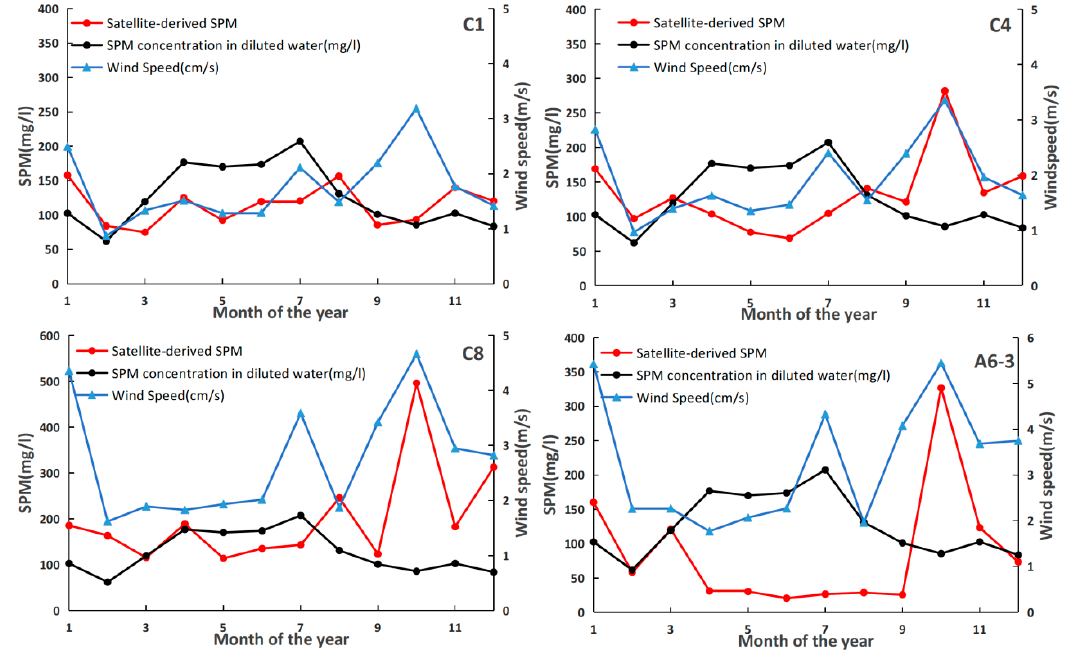
Figure 10. The wind speed and the Changjiang River sediments discharge at selected representative stations.